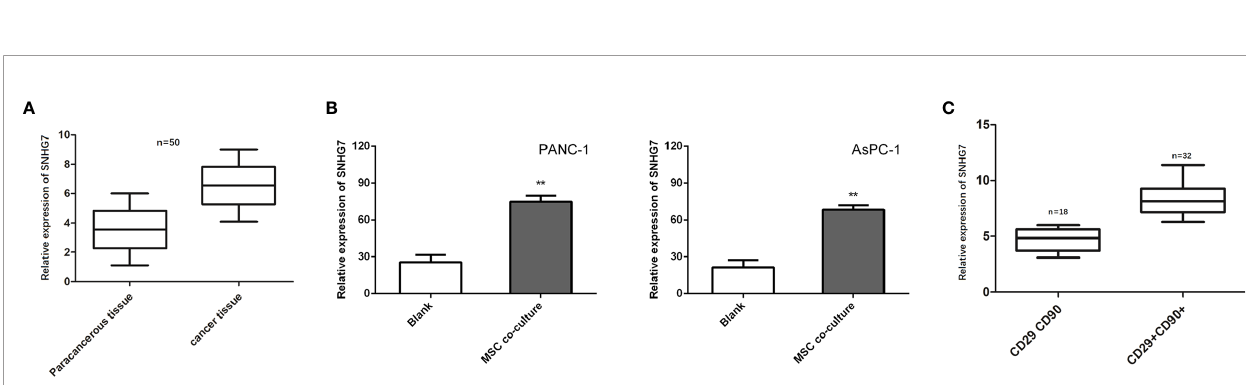
FIGURE 3 | SNHG7 is induced by MSCs and contributes to the stemness and Fol fi rinox resistance. (A, B) SNHG7 expression was determined via qRT-PCR in pancreatic cancer tissues or cells with or without co-culture of MSCs. (C) The correlation between SNHG7 expression and co-expression of CD29 and CD90 in pancreatic cancer tissues. **P <